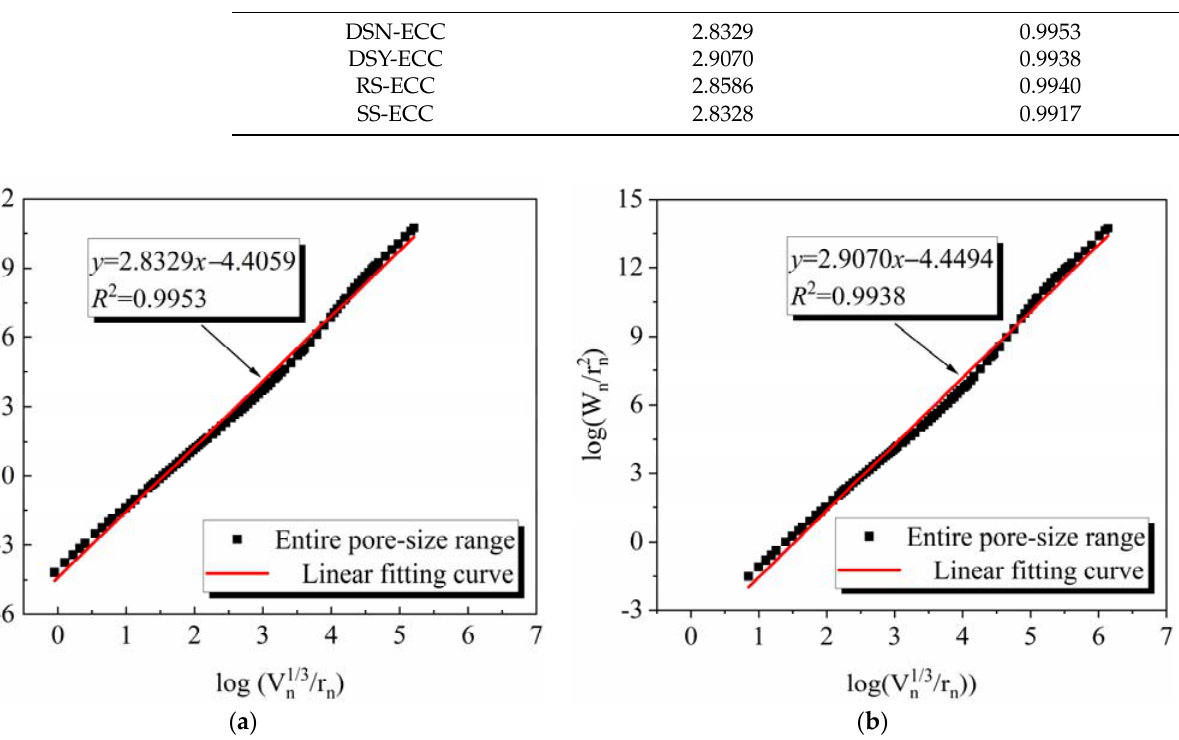
Figure 9. Pore diameter distribution of ECC under different fine aggregates.